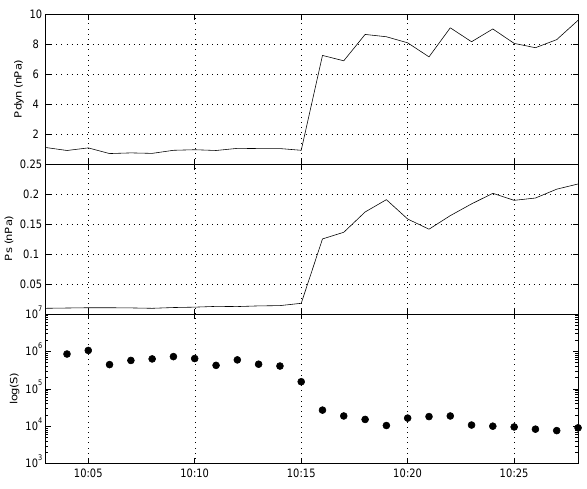
Fig. 9. Solar wind dynamic pressure, static pressure, and the S parameter (plotted logarithmically) for an interplanetary shock ob- served on 17 August 2001. Note the different scales in panels ( a ) and ( b ) showing dynamic and static pressures,